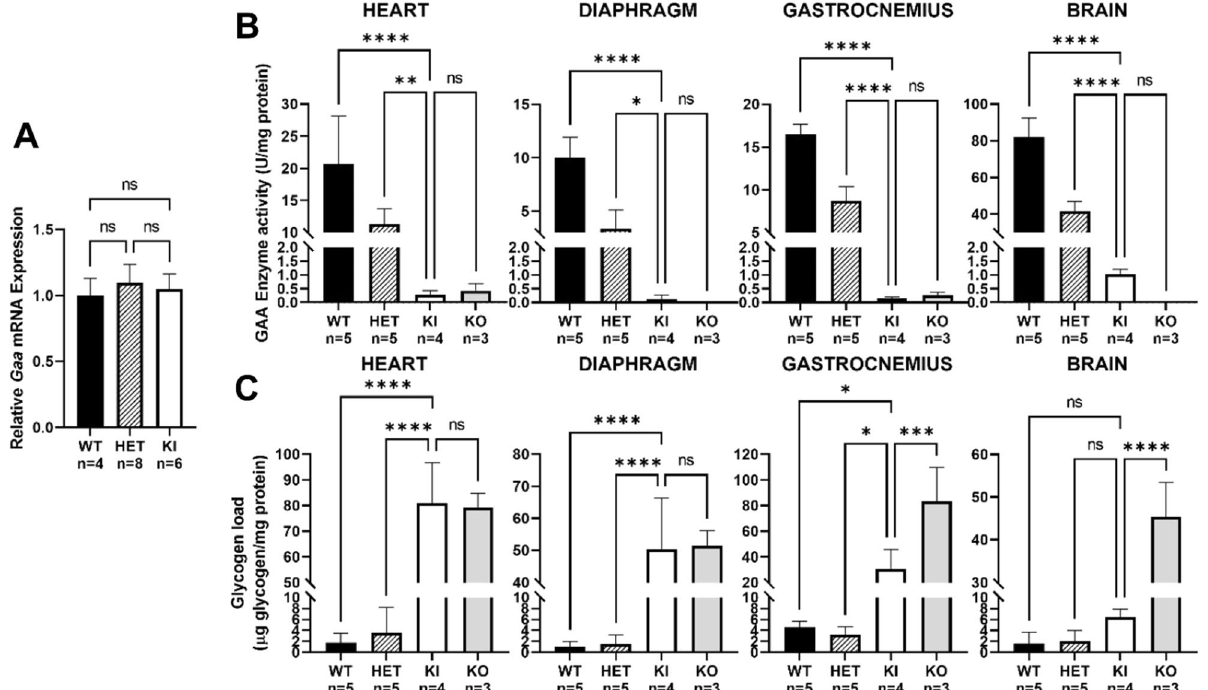
Figure 3. Molecular and biochemical characterization of Gaa em1935C > A KI mice. ( A ) Gaa mRNA expression in tail or liver biopsy samples from 3-month-old WT (n = 4; black bar), HET (n = 8; striped bar), and KI ( Gaa em1935C > A ; n = 6; white bar) mice Gaa expression levels were measured by TaqMan probe-based quantitative real-time PCR using the ΔC t method for comparison of the target gene ( Gaa ) to the reference gene ( Gapdh ). The average C t value from WT samples were further utilized to normalize with other groups. No significant difference in Gaa mRNA transcript expression was detected among WT, HET, and KI samples. ( B ) GAA enzyme activity in heart, diaphragm, and gastrocnemius muscle tissues and brain homogenate from WT (n = 5; black bars), HET (n = 5; striped bars), KI ( Gaa em1935C > A ; n = 4; white bars), and KO ( Gaa tm1Rabn ; n = 3; grey bars) mice was measured using a fluorometric 4-MU α-d-glucopyranoside assay and normalized to the amount of sample protein. ( C ) Glycogen level was measured in the same tissues used for analysis in ( B ) using a colorimetric assay. KO mice displayed significantly elevated glycogen levels relative to WT and HET mice in all tissues assayed. However, KI mice showed a significant elevation of glycogen levels in muscle tissues, but no significant elevation in brain. The amount of glycogen was normalized to the amount of sample protein. Data were generated from at least three independent experiments and shown as mean ± SD. All comparisons were analyzed using one-way ANOVA with the Tukey post-hoc test. * p < 0.05, ** p < 0.01, *** p < 0.001, **** p < 0.0001. ns: not